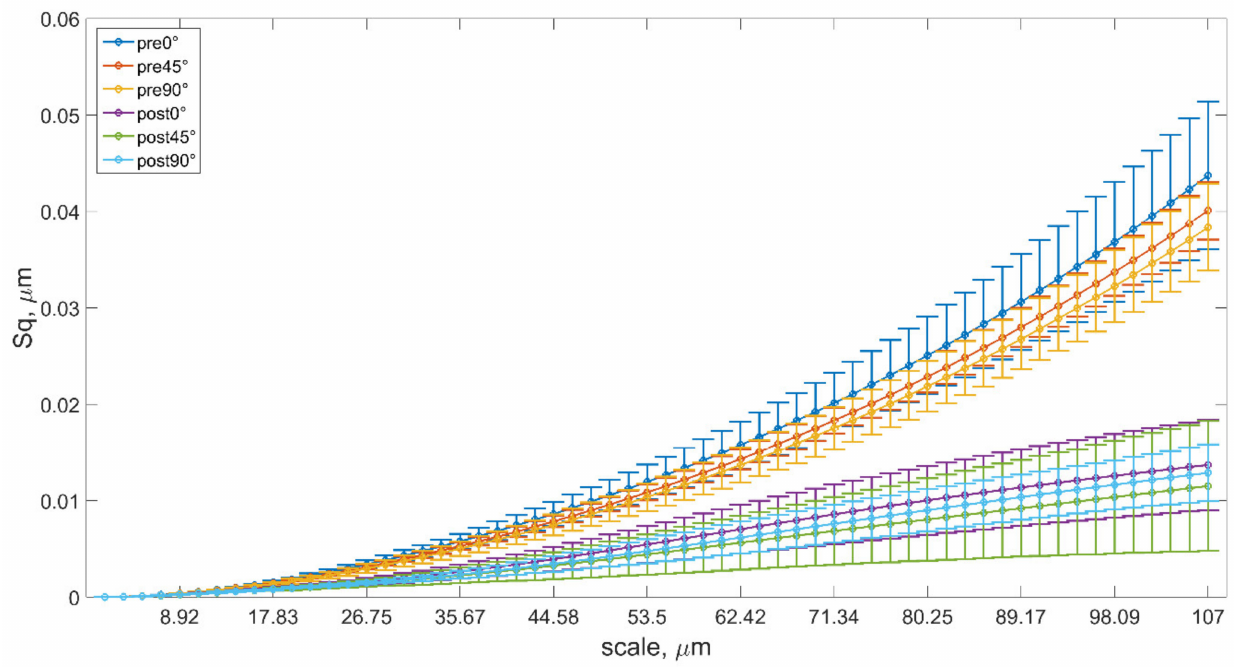
Figure 5. Evolution of root mean square height (Sq) with scale. Please note that “pre” and “post” terms refer to postprocess- ing via